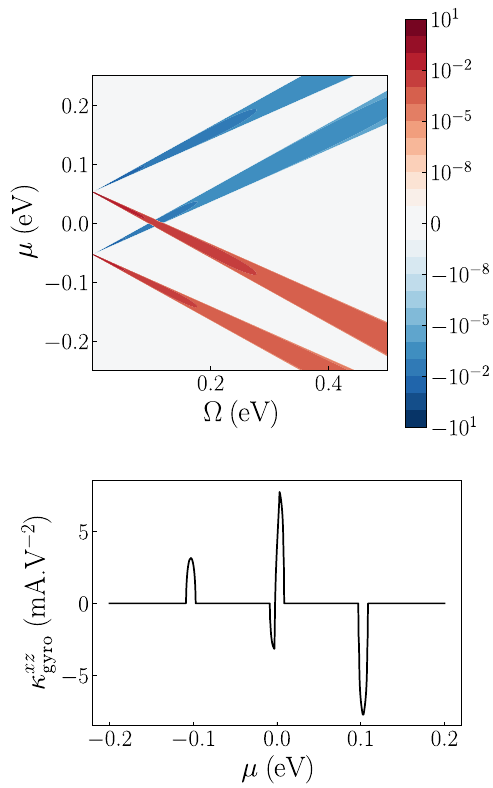
FIG. 6. Upper panel: chemical potential and frequency depend- ence of the gyration current coefficient in units of (A · V − 2 ). Lower panel: chemical potential profile of the gyration current coefficient for ℏ Ω ¼ 100 ð meV Þ